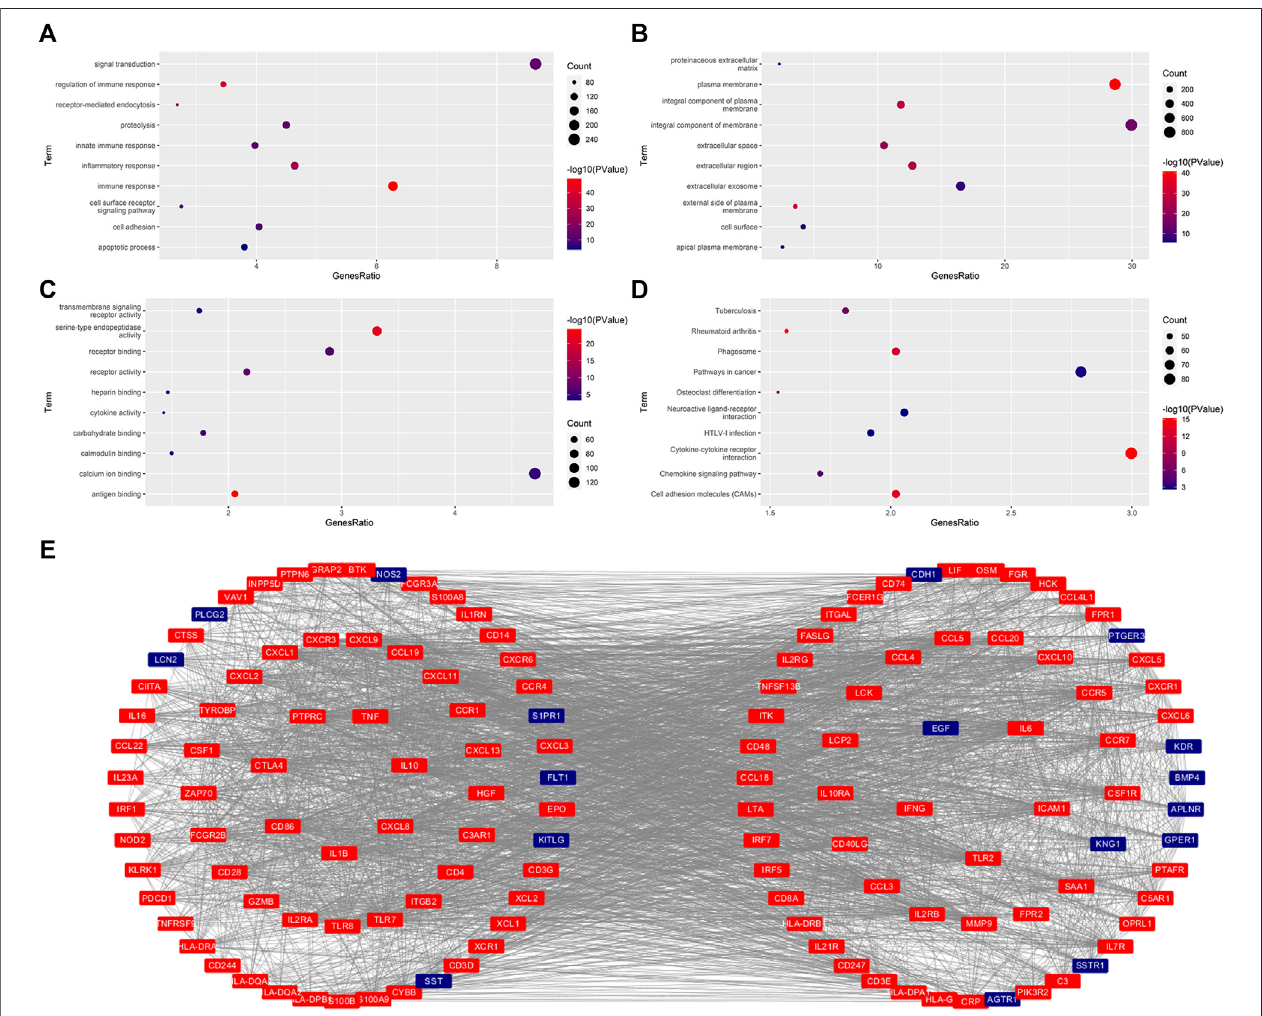
FIGURE 5 | Functional enrichment analysis and protein interaction analysis. (A – C) , The signi fi cantly enriched GO term (top 10). BP, Biological Process (A) . CC, Cellular Component (B) . MF, Molecular Functions (C) . (D) , The signi fi cantly enriched KEGG pathway (top 10). (E) , The protein interaction for these FR-DEGs with their degree ≥ average